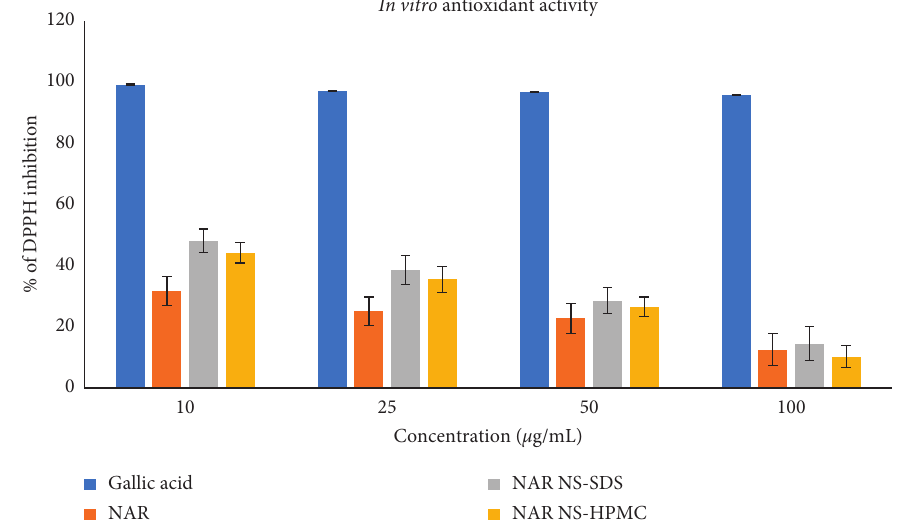
Figure 6: Percentage of DPPH free radical inhibition of NAR, SDS-stabilized NAR nanosuspension (NAR-NS-SDS), and HPMC-stabilized NAR nanosuspension (NAR-NS-HPMC) compared with standard gallic acid as a function of different concentrations of DPPH.